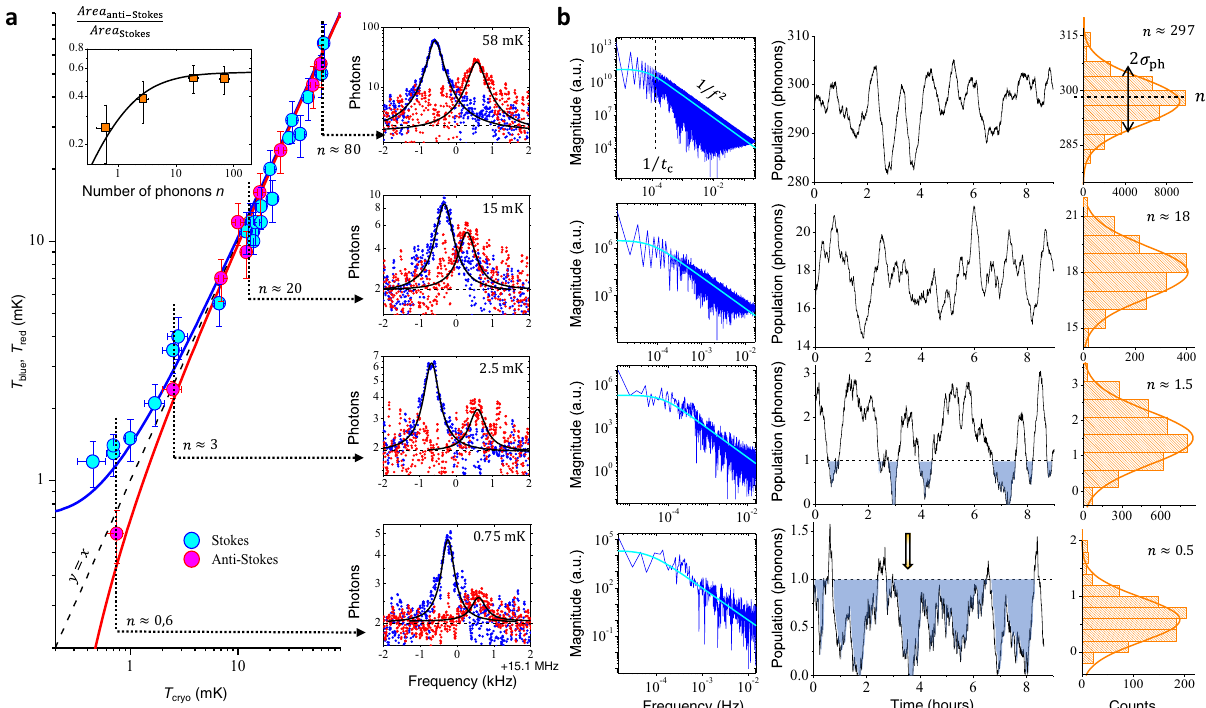
Fig. 2 Passive ground state cooling. a Main graph: the peak area of blue and red sideband pumping measurements leads to two different T blue , T red estimates, ∝ n + 1 and ∝ n (blue and red lines) respectively, a phenomenon known as sideband asymmetry 20 . Right insets: sideband peaks (blue and red colour for Stokes and anti-Stokes) measured for four different temperatures, with their Lorentzian fi ts (vertically shifted to two-photon baseline for readability). The slight shift in position (with respect to the actual ω m [ T ]) is due to a small remnant optical spring due to imperfect tuning of the pump frequency, whereas the difference in peak heights at high temperature is owing to the small amplifying/de-amplifying occurring at the fi nite input power we use (see text and Supplementary Note 2). The smallest Anti-Stokes peak required 4 days of continuous averaging. Left top inset: ratio of anti-Stokes and Stokes peak areas enabling sideband asymmetry thermometry (the black line is the theoretical expectation). b Measurement of in-equilibrium population fl uctuations at 220, 13, 1.4, and 0.65 mK (top to bottom) obtained with 20 minutes averaging time per point. Middle: time traces (9 h span) demonstrating very slow (and large, see also inset Fig. 1) fl uctuations. The shaded areas delimit the regions below 1 phonon. Left: spectrum (FFT transform of autocorrelation) showing a 1/ f 2 type dependence (full line fi t) with a low-frequency cutoff 1/ t c (dashed vertical). Right: corresponding histograms from which average n and standard deviation σ ph can be de fi ned (with Gaussian fi t displayed; the slight negativity for the two lowest graphs is due to the fi nite precision of the analysis procedure, see text and Supplementary Note 3). Error bars (type A uncertainty) mostly arise from the fi nite stability of mechanical parameters (frequency, damping, see Fig. 1) and are explained in Supplementary Note 3. Note the arrow on the central lowest time trace that points to a time slot where the measured population drops below our resolution for ~5 mins (see